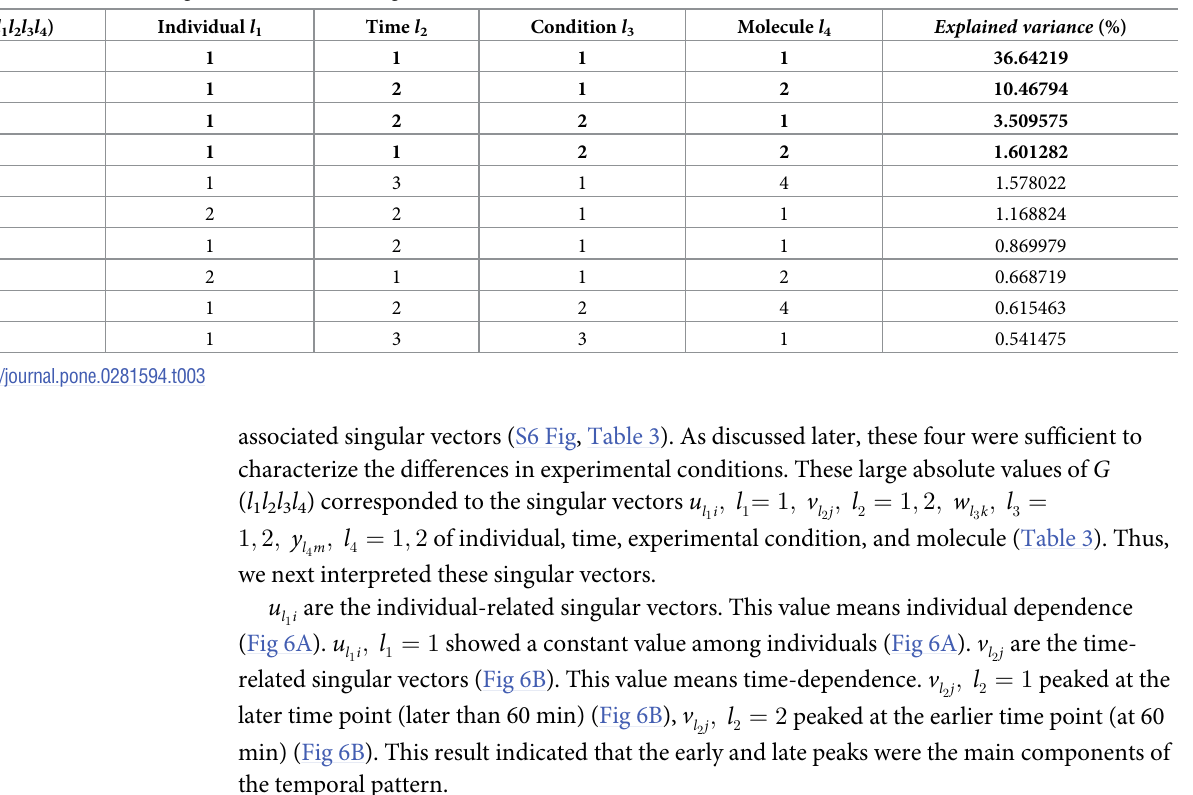
Table 3. Top ranked 10 G( l 1 l 2 l 3 l 4 )s with larger absolute values among l 1 , l 2 , l 3 , l 4